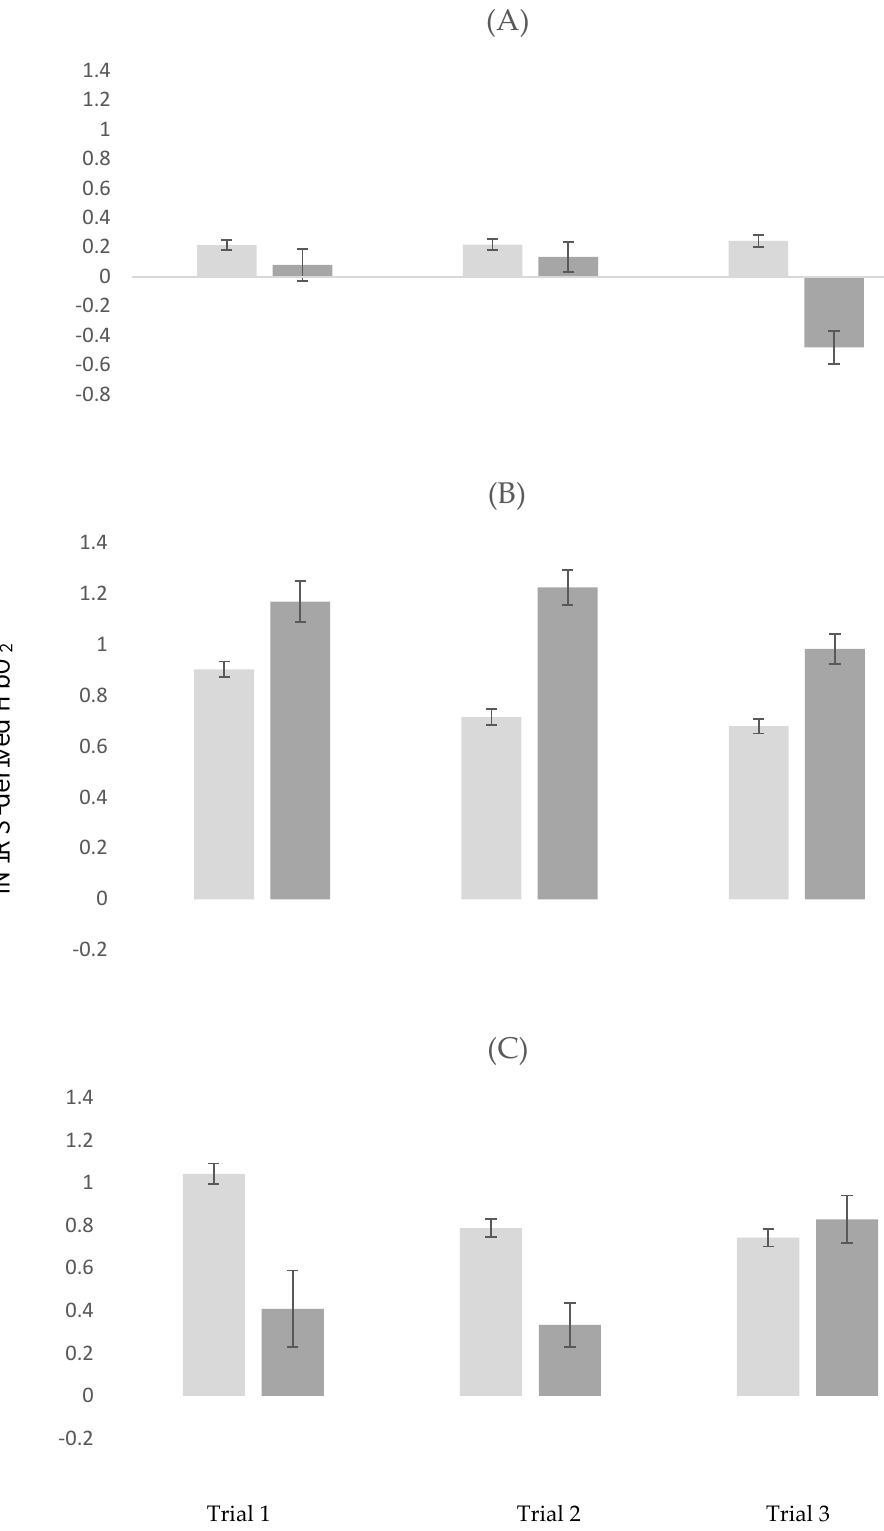
Figure 2. Changes in fNIRS-derived HbO 2 across repeated trials stratified by task conditions in MCI and control participants. Light Grey: Control Participants; Dark Grey: MCI Participants; ( A ) repeated trials in STW (Single-Task-Walk); ( B ) repeated trials in Alpha (Cognitive Interference Task); ( C ) repeated trials in DTW (Dual-Task-Walk); MCI: Mild Cognitive Impairments.